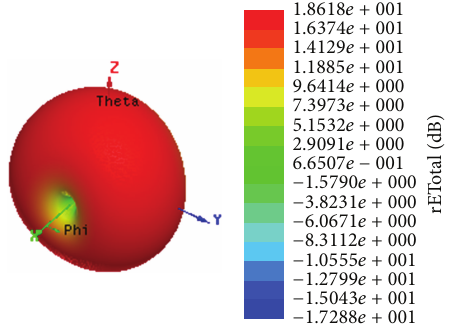
Figure 7: Simulated 3D radiation pattern plot for 6 GHz.